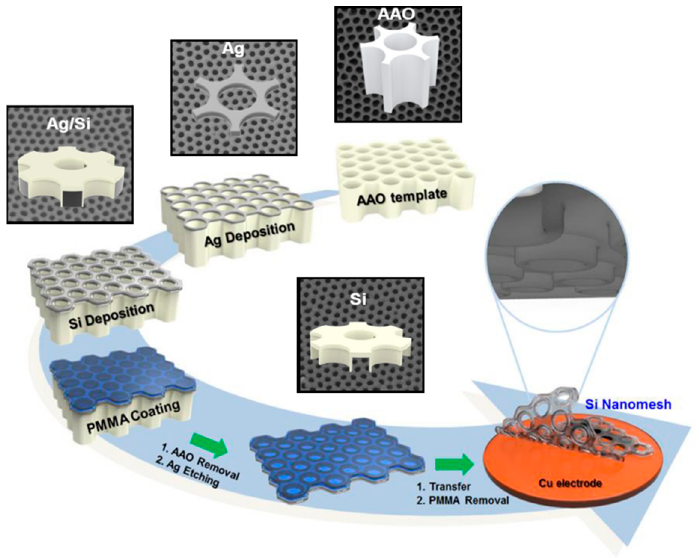
Figure 2. AAO-directed low-tortuous Si nanomesh electrode. Reproduced with permission from ref. [32]. Copyright 2017, Elsevier. ref. [32]. Copyright 2017,